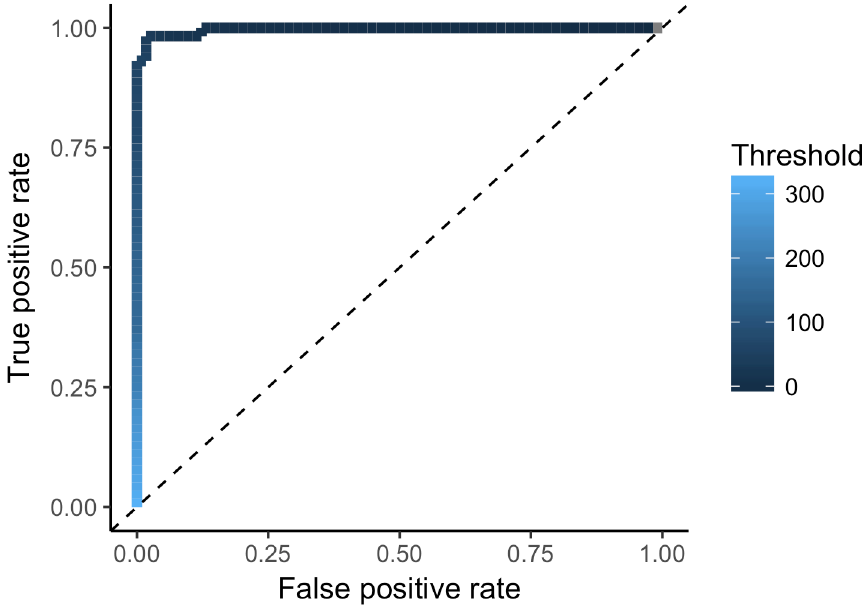
Fig 2. Receiveroperator characteristic (ROC) curve of antigen ELISA detection of T . serialis infection in dried gelada urine. The optimalthresholdcutoff index value (42.1) had an estimated specificity of 98.4%